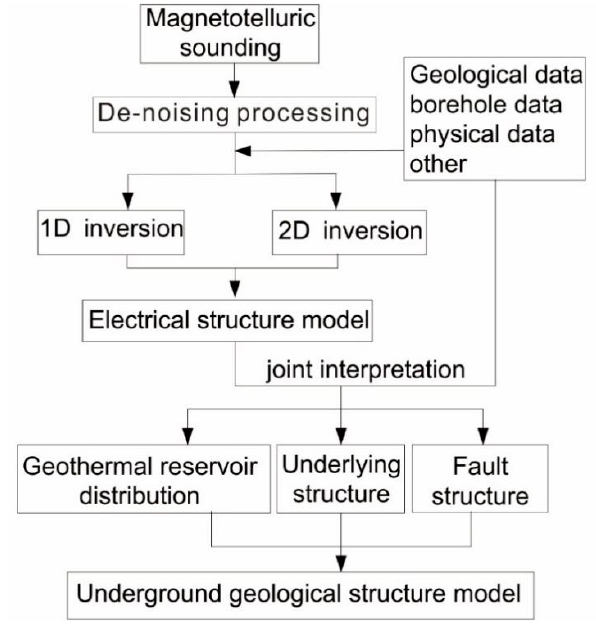
Figure 3. Inversion and interpretation processes of MT.